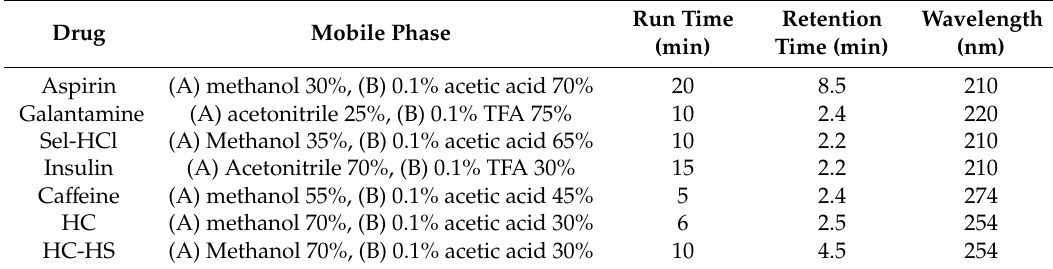
Table 3. HPLC conditions for each